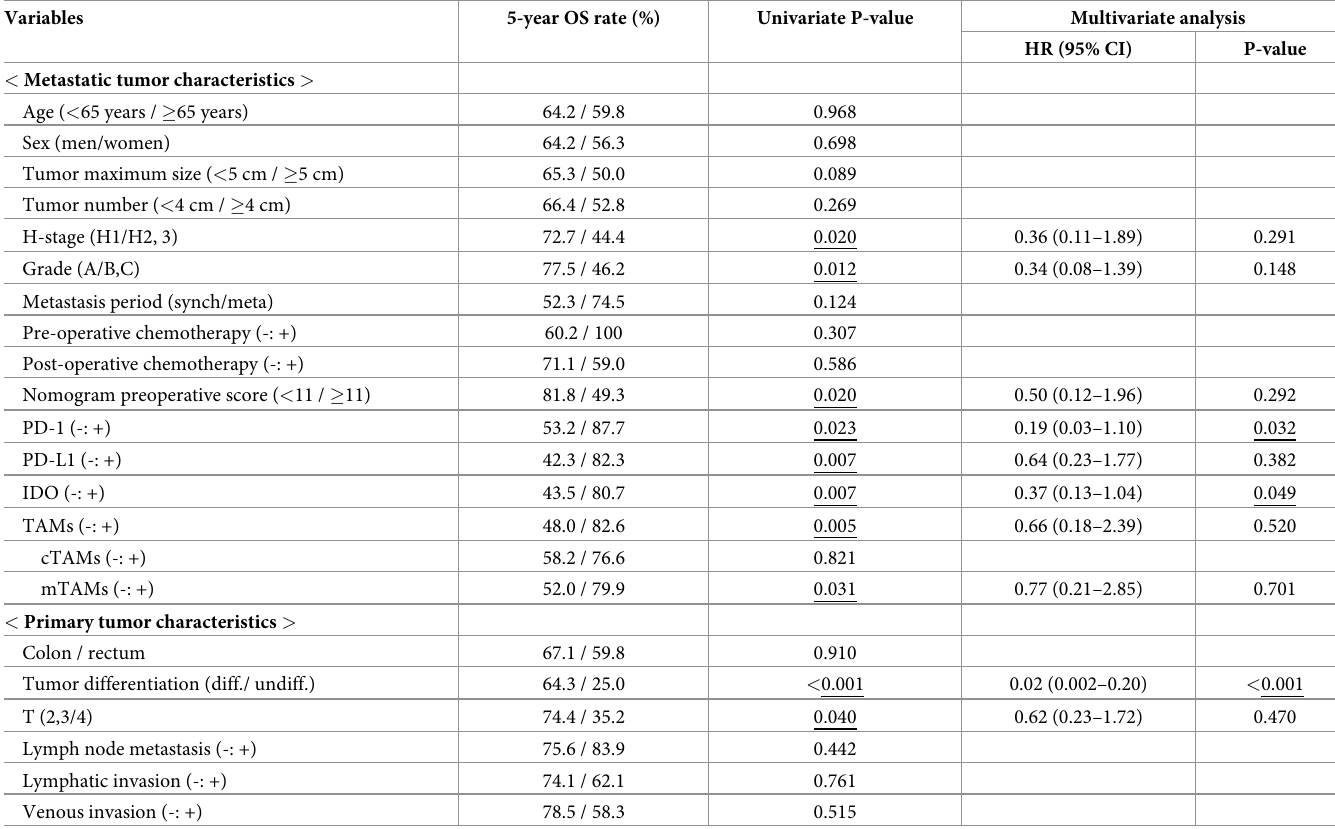
Table 5. Univariate and multivariate analysis of clinicopathological factors associated with overall survival post-hepatectomy.